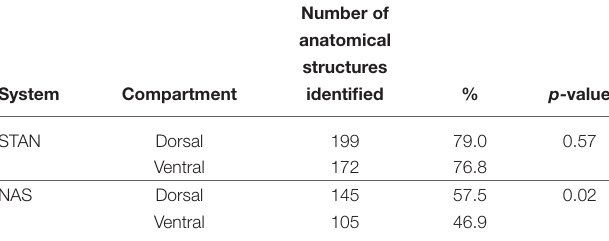
TABLE 3 | A comparison between arthroscope systems by joint compartment. Number of